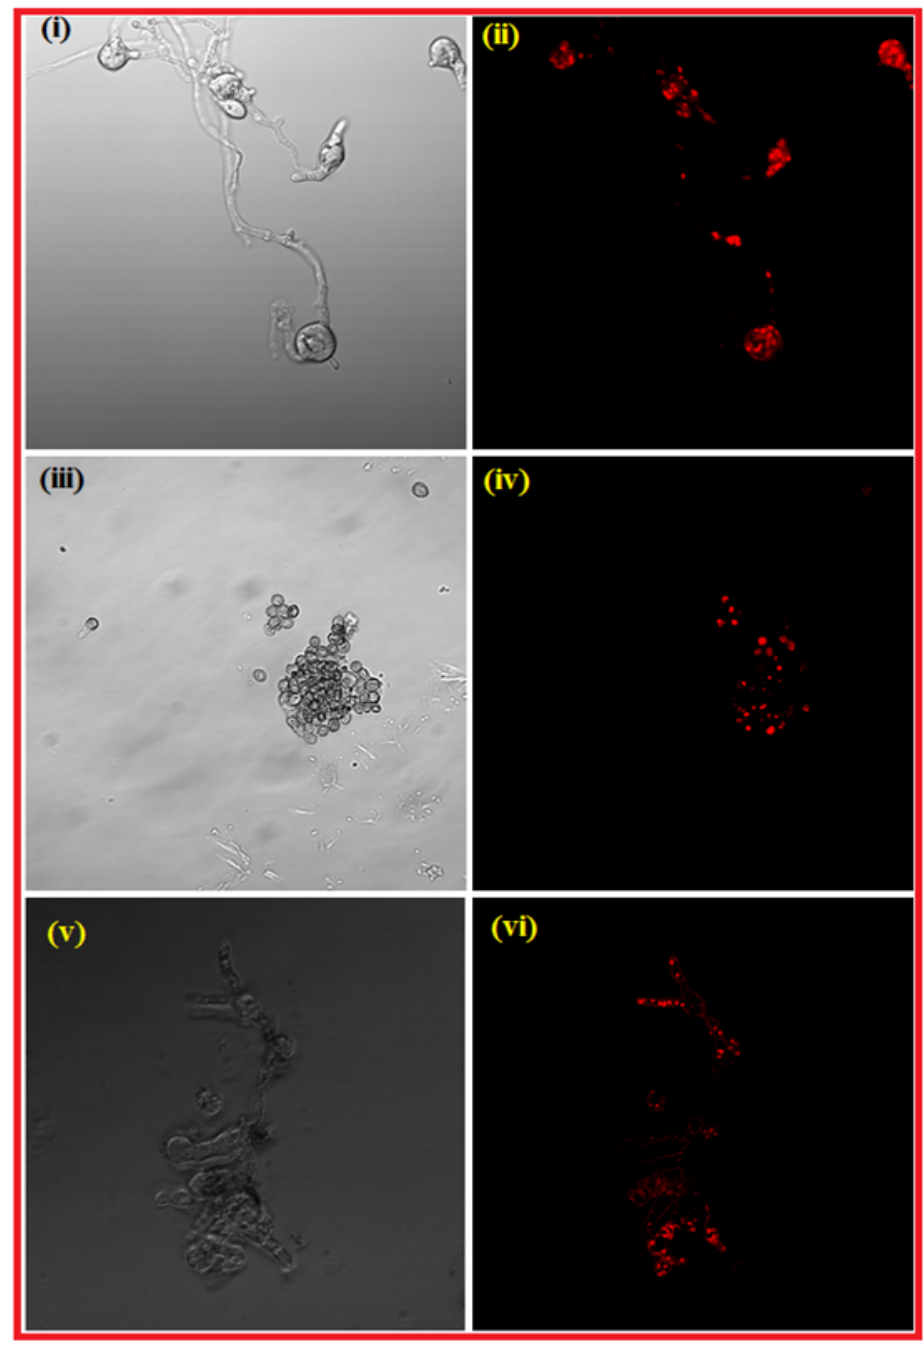
Figure 6. ( a ). Showing the confocal laser scanning microscopy of R. arrhizus sporangiospores treated with PEI-f-Ag-NPs and control stained with PI dye, for 24 h along with their respective DIC images. ( i , ii ) control sporangiospores; ( iii , iv ) treated with amphotericin B; ( v , vi ) treated with PEI-f-AgNP-1 and ( vii , viii ) treated with PEI-f-AgNP-2. ( b ). Showing the confocal laser scanning microscopy of R. arrhizus sporangiospores treated with PEI-f-Ag-NPs and control stained with PI dye, for 48 h along with their respective DIC images. control sporangiospores ( i , ii ); ( iii , iv ) treated with PEI-f-AgNP-1 and ( v , vi ) treated with PEI-f-AgNP-2. ( c ). Showing the confocal laser scanning microscopy of R. arrhizus sporangiospores treated with PEI-f-Ag-NPs and control stained with PI dye, for 72 h along with their respective DIC images. ( i , ii ) control sporangiospores; ( iii , iv ) treated sporangiospores with PEI-f-AgNP-1; and ( v , vi ) treated with PEI-f-AgNP-2.